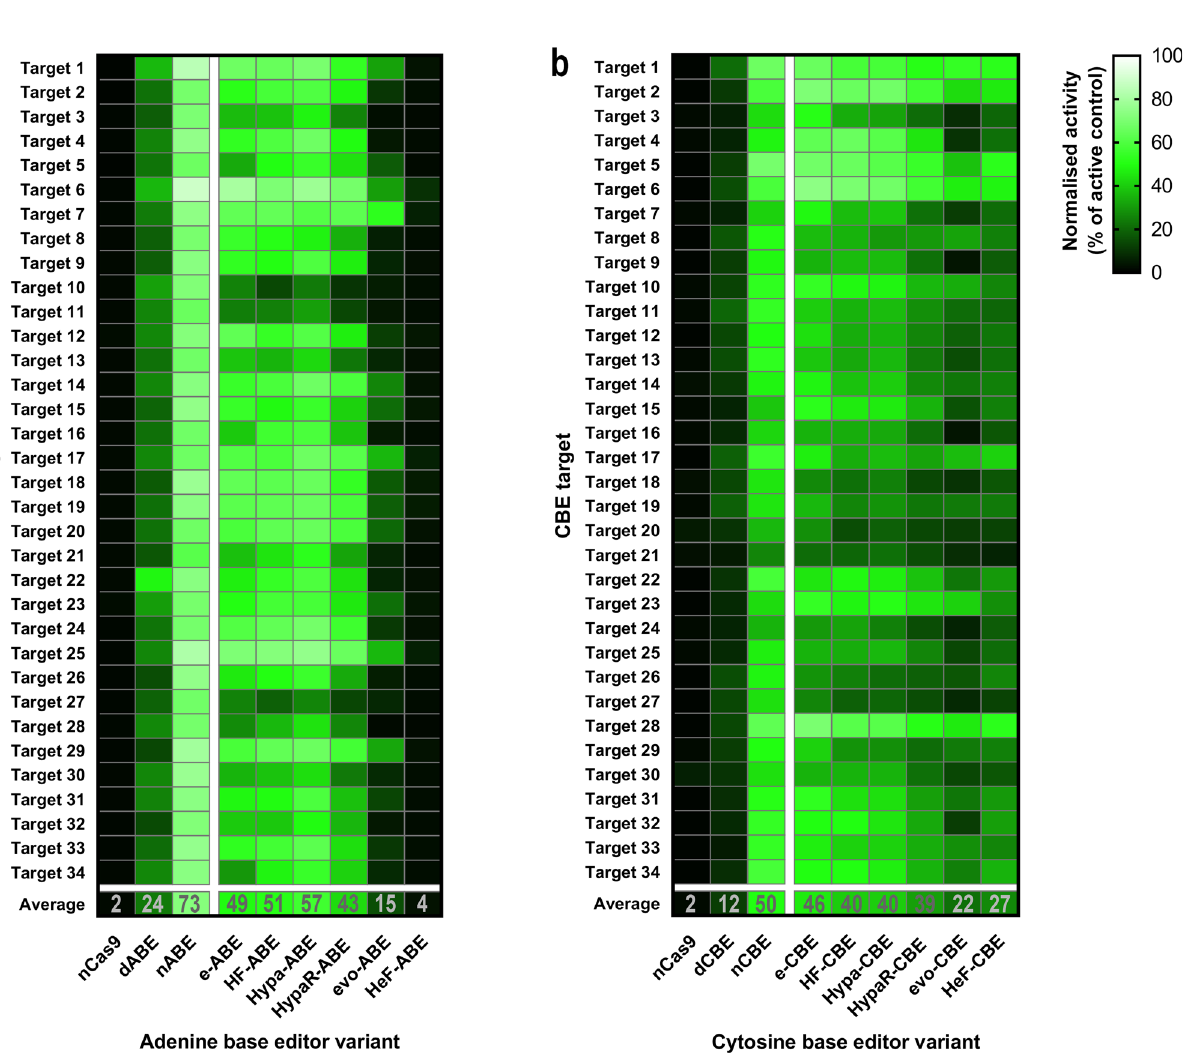
Fig. 4 Enrichment of dABE and dCBE base edited cells with BEAR, matches the ef fi ciency of nABE and nCBE while creating less indels. a Either the BEAR-mScarlet or the BEAR-GFP plasmid and dABE were co-transfected into the BEAR-GFP or BEAR-mScarlet cell line and the cells were analysed by fl ow cytometry gated for GFP or mScarlet positive cells, respectively. Cells without additional gating: no enrichment (black bars) with additional BFP gate: transfection enrichment (grey bars), with additional BEAR-plasmid colour gate: BEAR enrichment (purple bars). To monitor transfection ef fi ciency a blue fl uorescent protein (BFP) was placed onto the sgRNA-expressing plasmid. b The target sequences of the endogenous genomic targets edited with CBE or ABE variants in panels c and f . Bases edited most ef fi ciently are coloured and their ef fi ciencies are depicted on panels c and f . For all other edited bases and editing ef fi ciencies see the Source Data fi le. The BEAR-GFP-2in1 plasmid and endogenous genomic targets were co-edited by dCBE ( c – e ) and dABE ( f – h ) and analysed by NGS. Edited cells were sorted to 3 fractions: all cells (no enrichment, black), BFP positive cells (transfection enrichment, grey), and cells with GFP positivity representing base editing enriched cells (dCBE – light green, dABE – light purple). In all experiments nCBE (dark green) and nABE (dark purple) edited cells were monitored without enrichment as controls. Base editing and indel formation was quanti fi ed from the same samples in the case of dCBE ( c , d ) and dABE ( f , g ) edited cells. The speci fi city (base editing % / indel %) is displayed for nCBE and dCBE ( e ) as well as for nABE and dABE ( h ). Columns represent means± SD of three parallel transfections (grey circles). When indel % was lower than the detection limit of NGS (dashed grey line, 0.05%), speci fi city was calculated with 0.05% indel to avoid falsely high speci fi city values. Differences between samples were tested using one-way